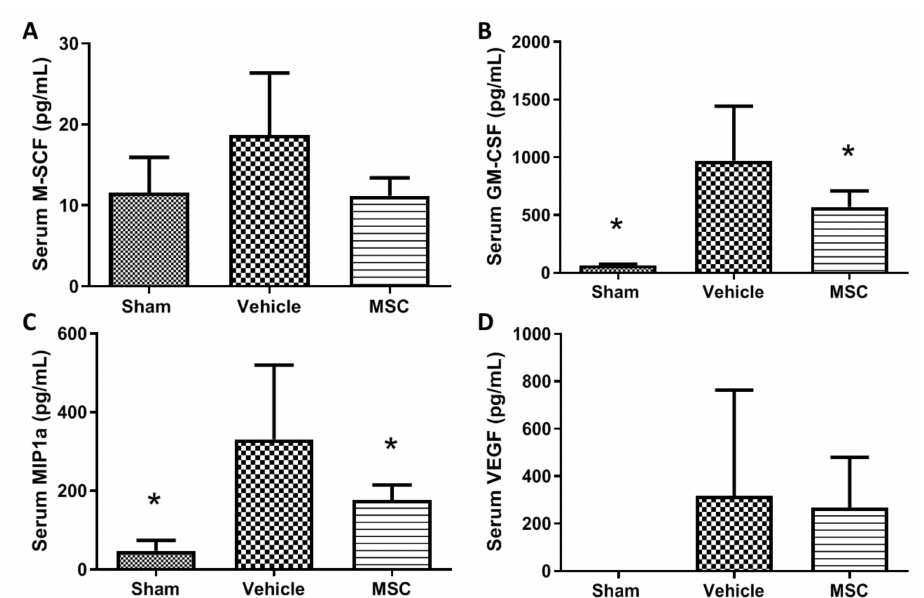
Figure 6. Other systemic soluble factor expression after CD362 + UC-MSC administration. Levels of circulating macrophage colony-stimulator factor (M-CSF) ( A ), granulocyte-macrophage colony-stimulating factor (GM-CSF) ( B ), MIP-1 α ( C ) and vascular endothelial growth factor (VEGF) ( D ) in serum were reduced in the CD362 + UC-MSC treated group compared with vehicle administration. Bars represent mean ( n = 3 / 8 / 8), error bars represent SD. * Statistically significant ( p < 0.05) with respect to vehicle control